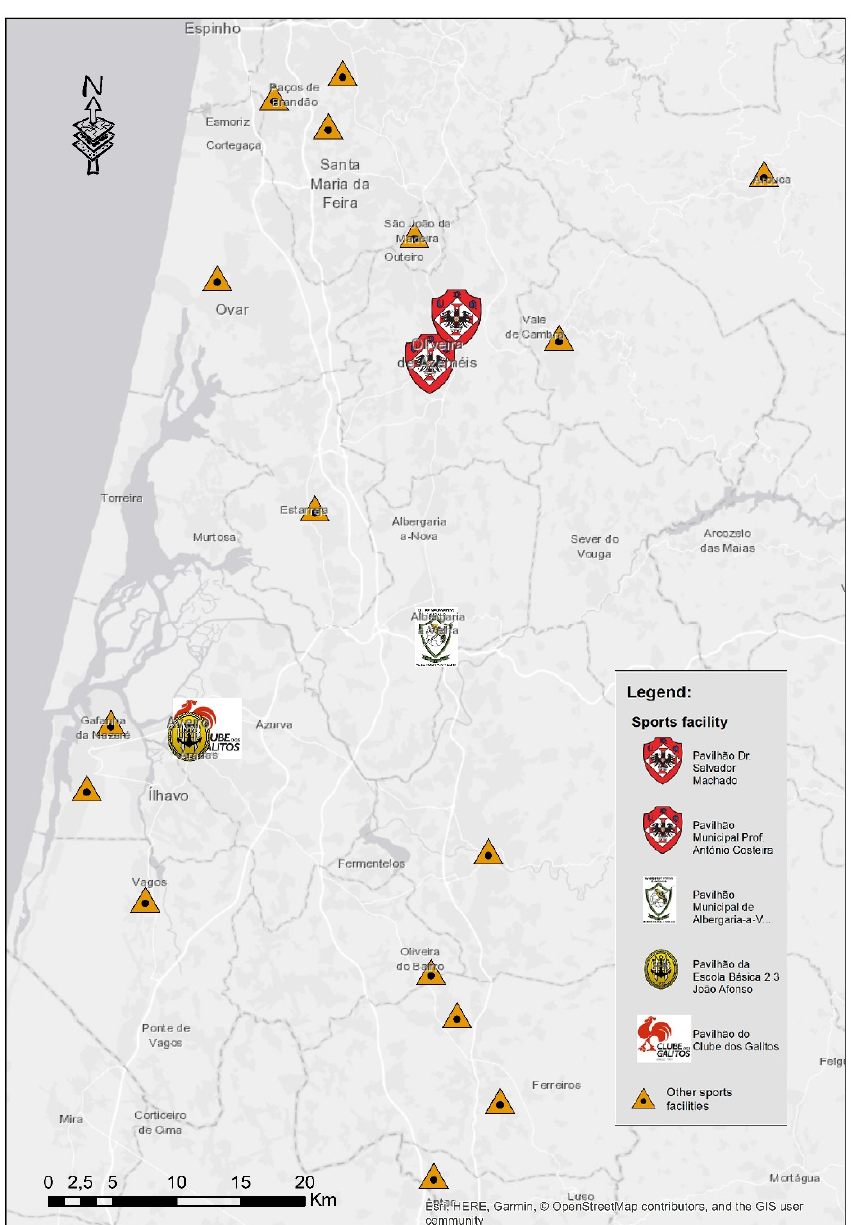
Figure 1. Location of clubs’ infrastructures (Aveiro District) .